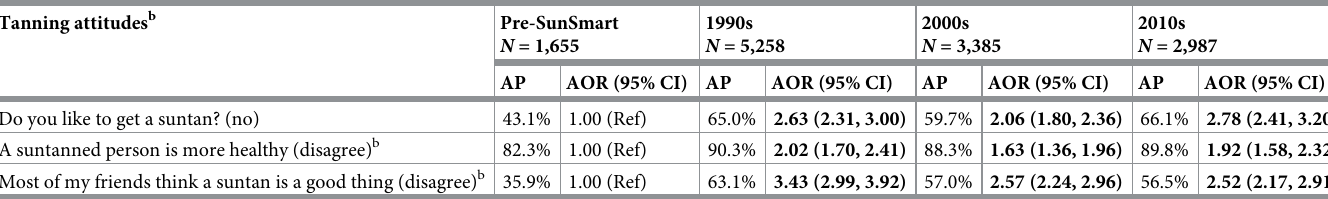
Table 2. Changes in tanning attitudes among Melbourne residents by decade, relative to before the SunSmart program. a